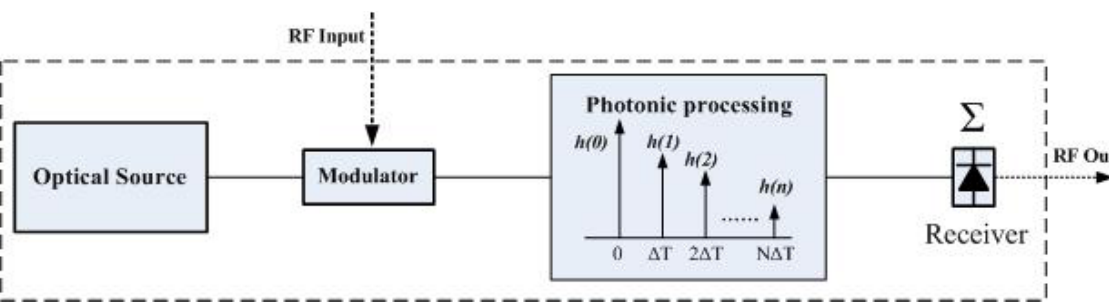
Figure 11. The structure of a typical time delay based microwave photonic